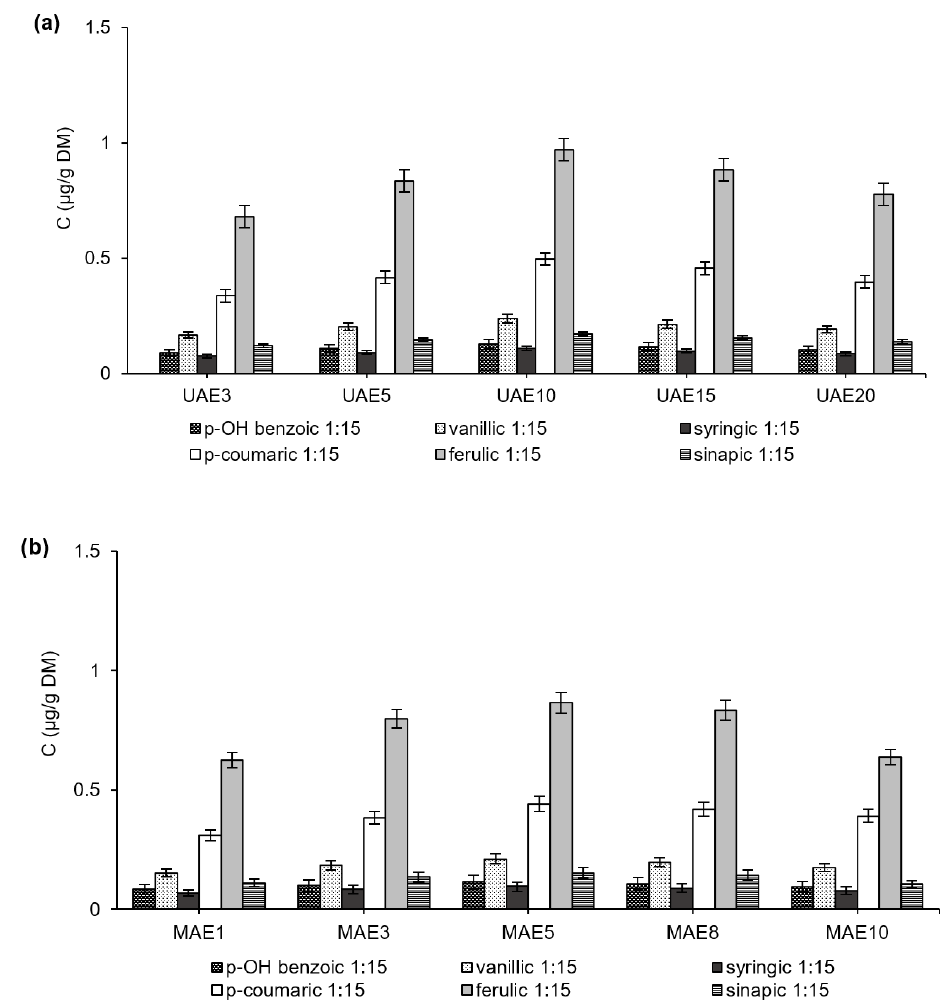
Figure 4. Concentrations of individual phenolic acids in extracts from UAE ( a ) and MAE ( b ) with 60% acetone. In the abbreviations used to refer to the series, the values after UAE and MAE indicate the extraction time.